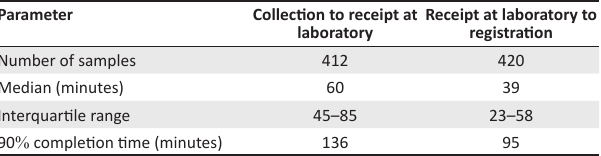
TABLE 3: Summary of phases between collection to registration of full blood count samples at the haematology outpatient department for the month of April 2018 at Tygerberg Academic Hospital in Cape Town, South Africa. Parameter